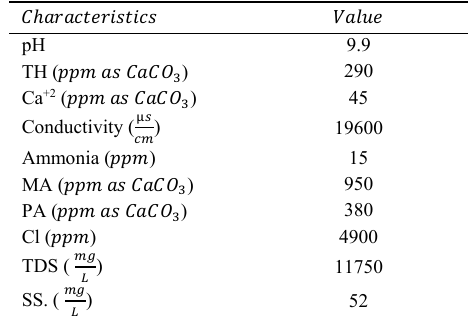
Table 2: Characteristics of the wastewater containing ammonia